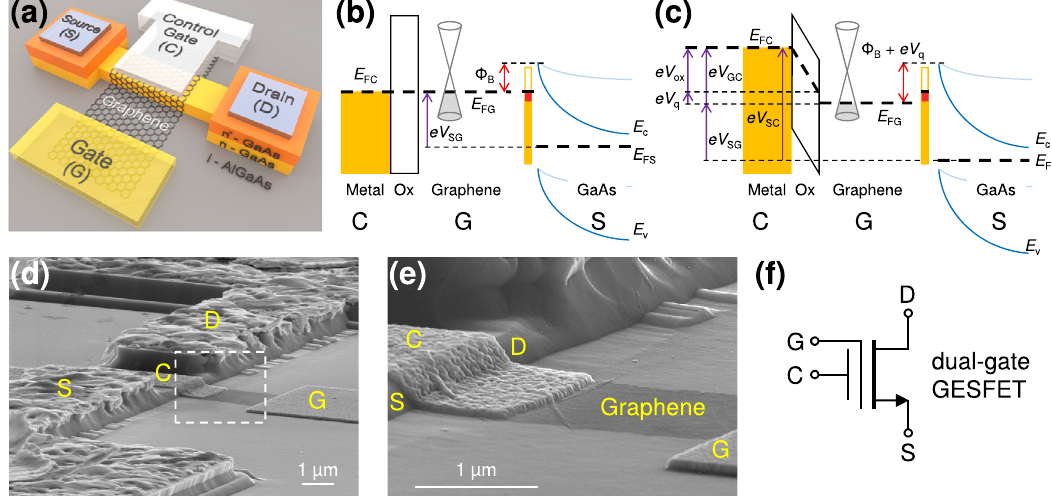
Fig. 2 Dual-gate GESFET. a A schematic of a dual-gate GESFET which differs from the standard (single-gate) GESFET in having a control gate (C; white) fabricated on top of the graphene gate. b The equilibrium band diagram of a dual-gate GESFET in the vertical direction, i.e., from the control-gate stack, comprising gate metal (C) on top of gate oxide (Ox), to the graphene gate (G), surface states (orange bar) and n-GaAs channel (S). The diagram is drawn for V GC = 0 V (i.e., when the control gate is connected to the graphene gate) and V GS < 0 V (i.e., when the channel is depleted). The SBH is Φ B . c The same band diagram for V GC > 0 V, i.e., when the voltage between the graphene and control gate is used to increase the SBH to Φ B + eV q , where V q is the voltage drop between graphene and its metal contact. V ox is the voltage drop on the gate oxide, i.e., V GC = V ox + V q . d A SEM image of a dual-gate GESFET. The top surface of the source and drain contacts is n + -GaAs layer which became rough after annealing. e The enlarged part of the previous image within the enclosed white dashed rectangle. f The proposed circuit symbol of a dual-gate